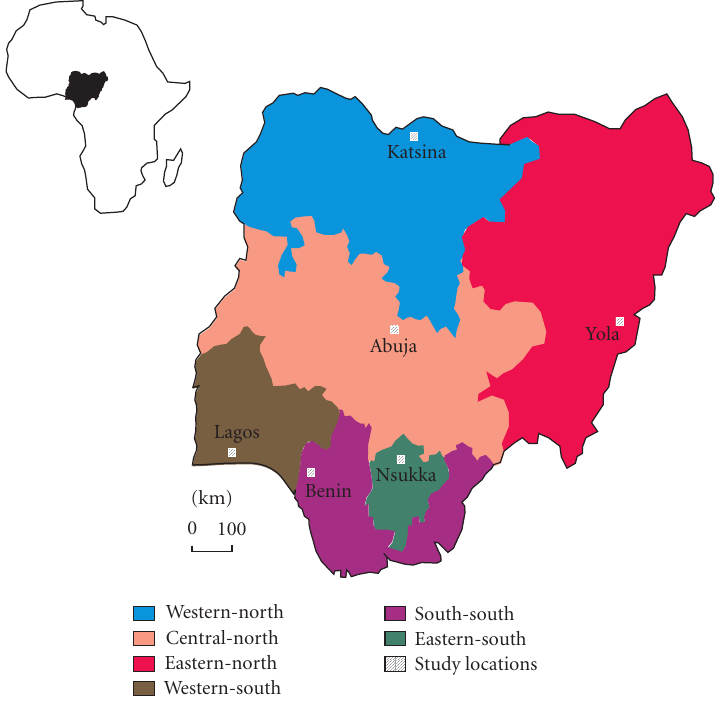
Figure 1: Site map of study locations.